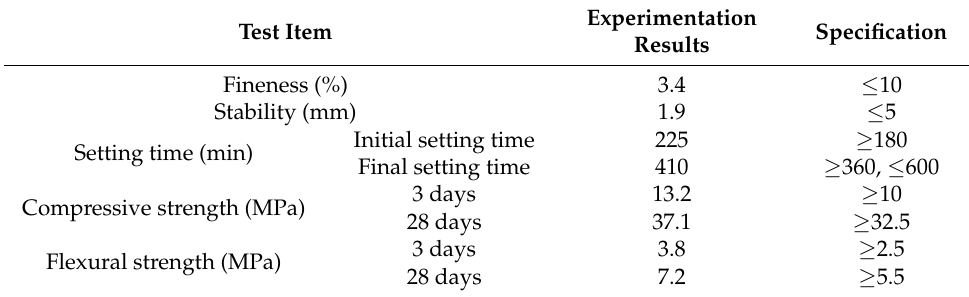
Table 1. Results of cement performance